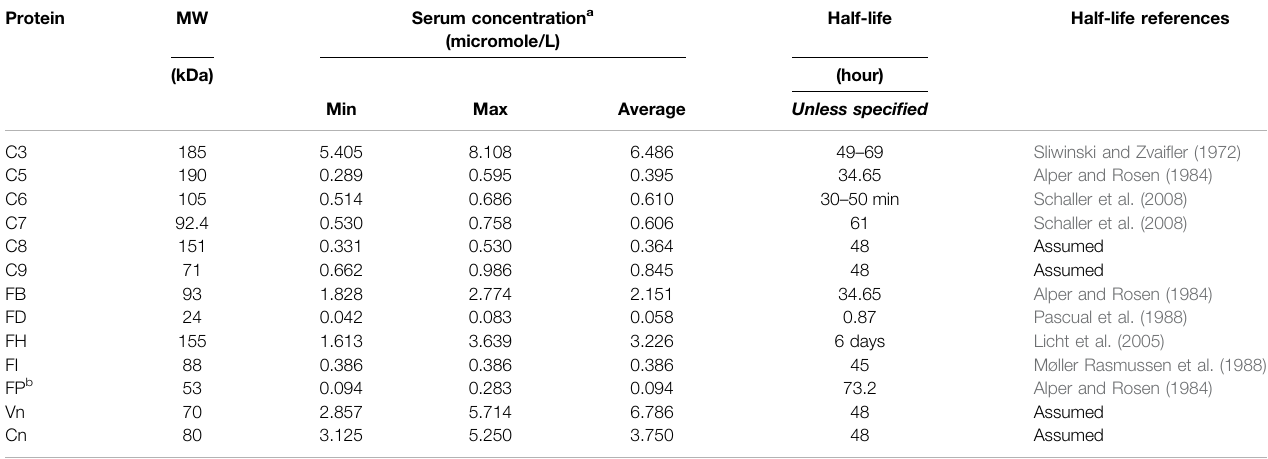
TABLE 1 | Complement protein levels in healthy state in humans and their half-lives.